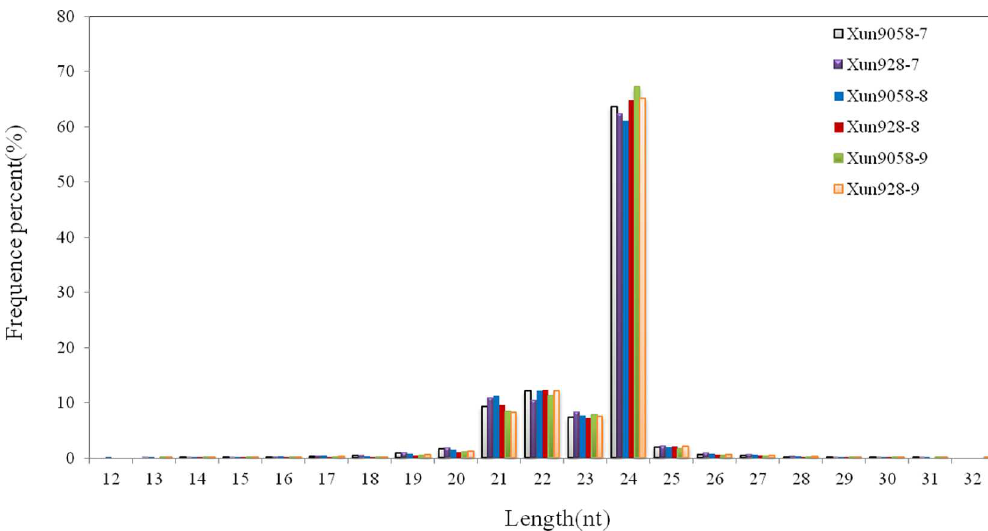
Fig 1. Length distribution of small RNAs obtained from the six maize internode libraries. The 24 nt was the most abundant size of the small RNAs, accounting for ~60% at each